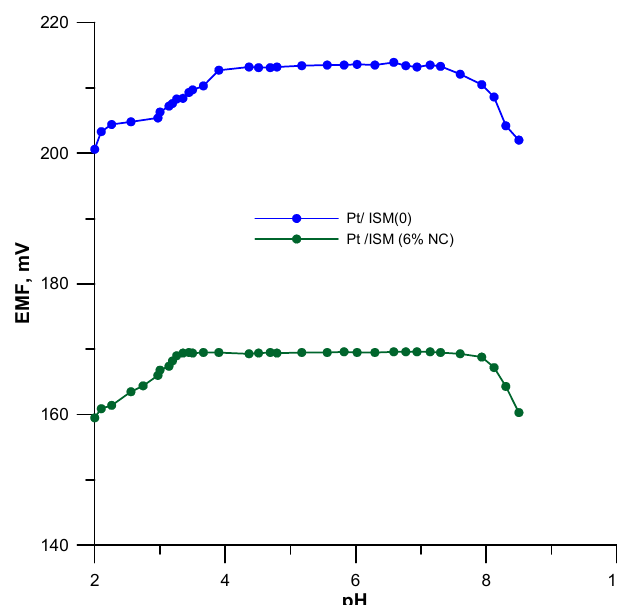
Figure 6. Effect of pH on electrode potential.